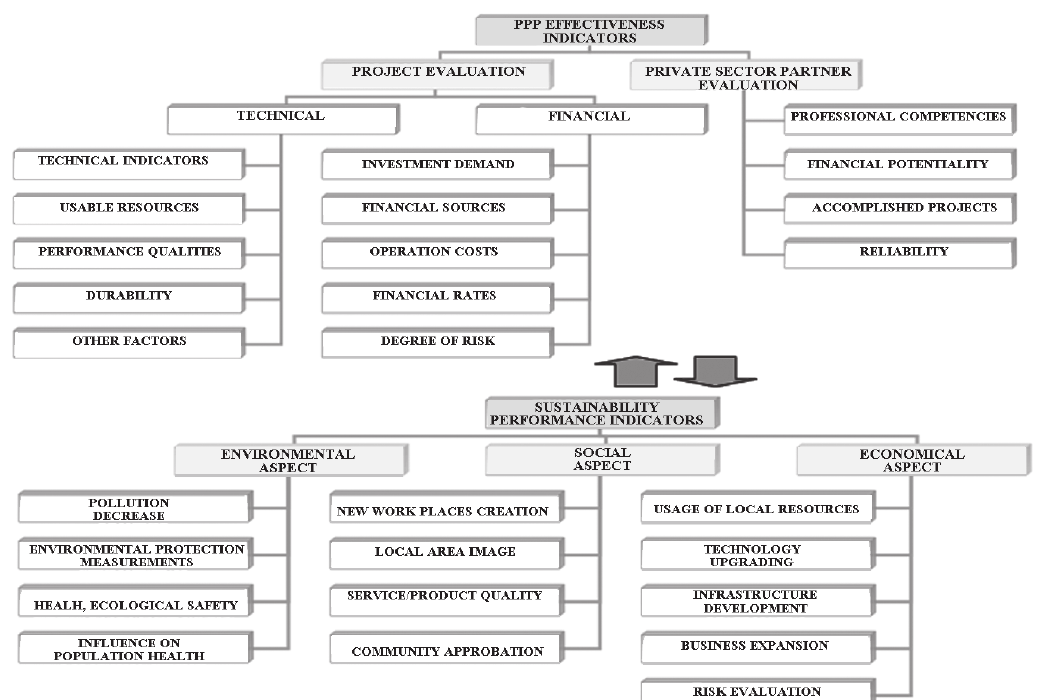
Fig. 1. Model of PPP infrastructure project effectiveness